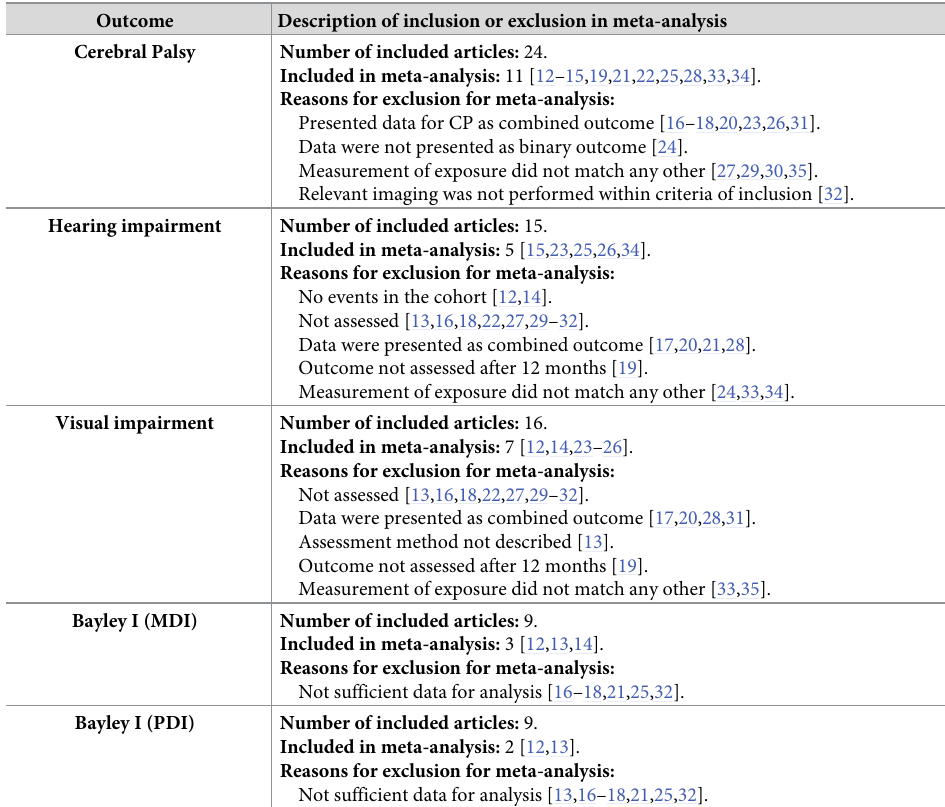
Table 1. Articles used in meta-analysis, sorted by outcomes with reasons for exclusion.